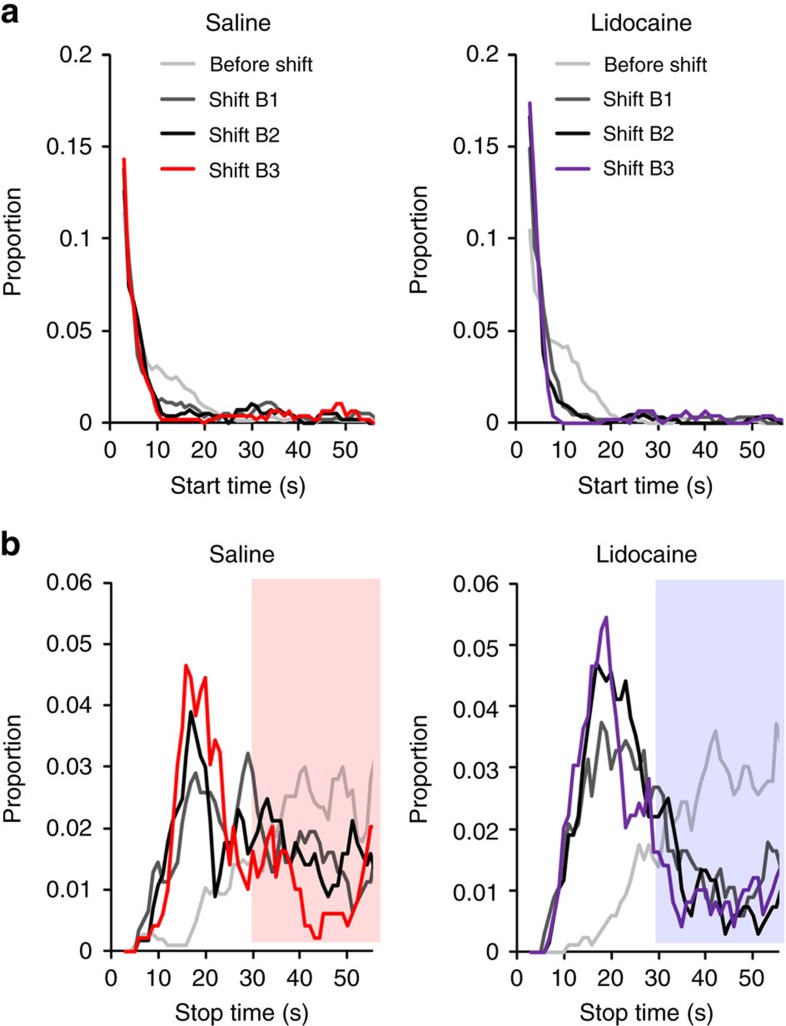
Intra-amygdala infusion of lidocaine facilitates extinction of responding associated to the old duration.The figure shows the distribution of the times at which rats started to suppress after the CS onset ((a), start times) and at which they resumed back to their baseline lever-pressing ((b), stop times) when the CS–US interval was shifted from 30 s (before shift) to 10 s (for 3 blocks of 4 sessions). Stop times appeared to reflect both learning of the new duration (stops between 10 and 30 s) and extinction of the oId one (stops >30 s, shaded area) in the saline group (n=10), whilst in the lidocaine group (n=9), extinction of responding to the old time was already optimal early on after the shift.